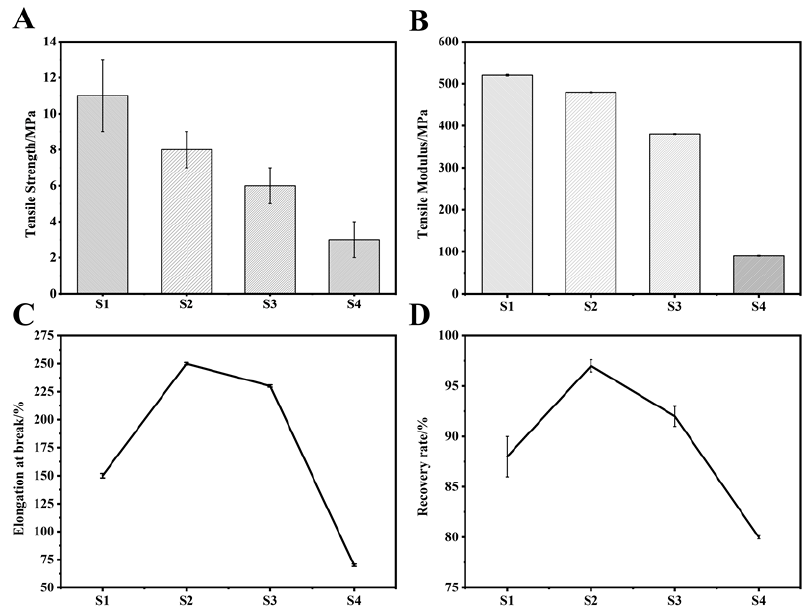
Figure 6. Analysis of mechanical properties of S1–S2; ( A ) Elastic strength; ( B ) Elastic modulus; ( C ) Elongation at break; ( D ) Recovery